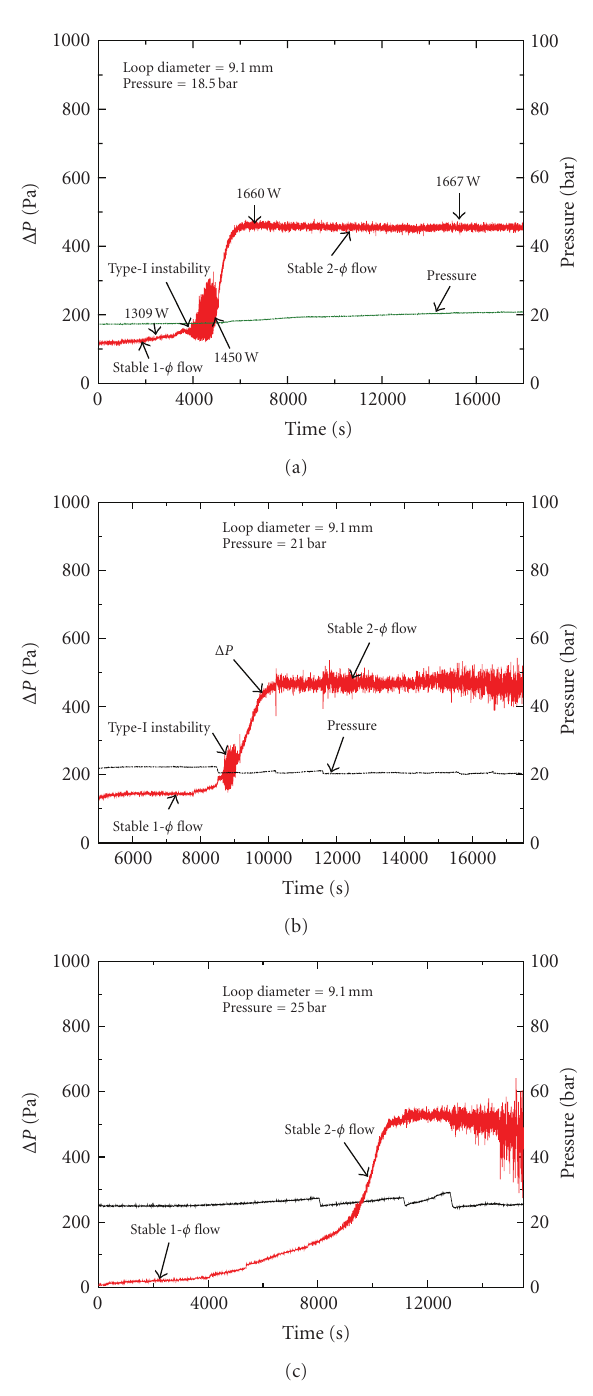
Figure 17: E ff ect of pressure on the type-I instability in the 9.1 mm inside diameter loop.